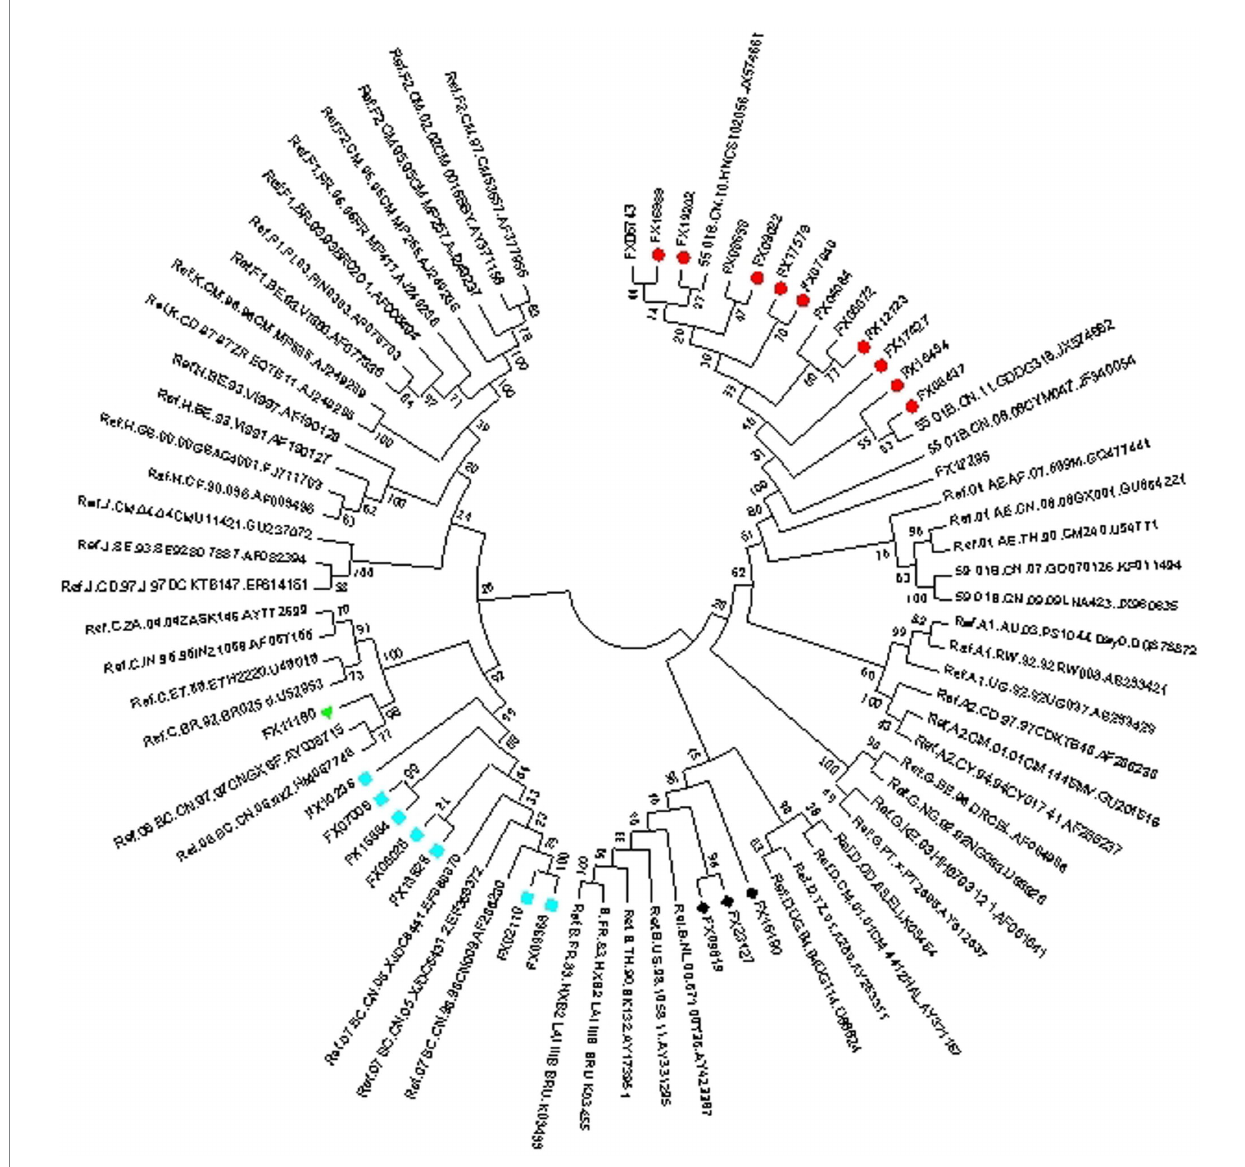
FIGURE 2 Phylogenetic tree (for HIV-1 subtype confirming) of X4-tropism in CRF07_BC (the cyan square), CRF08_BC (the green triangle), CRF55_01B (the red circle), and subtype B (the black